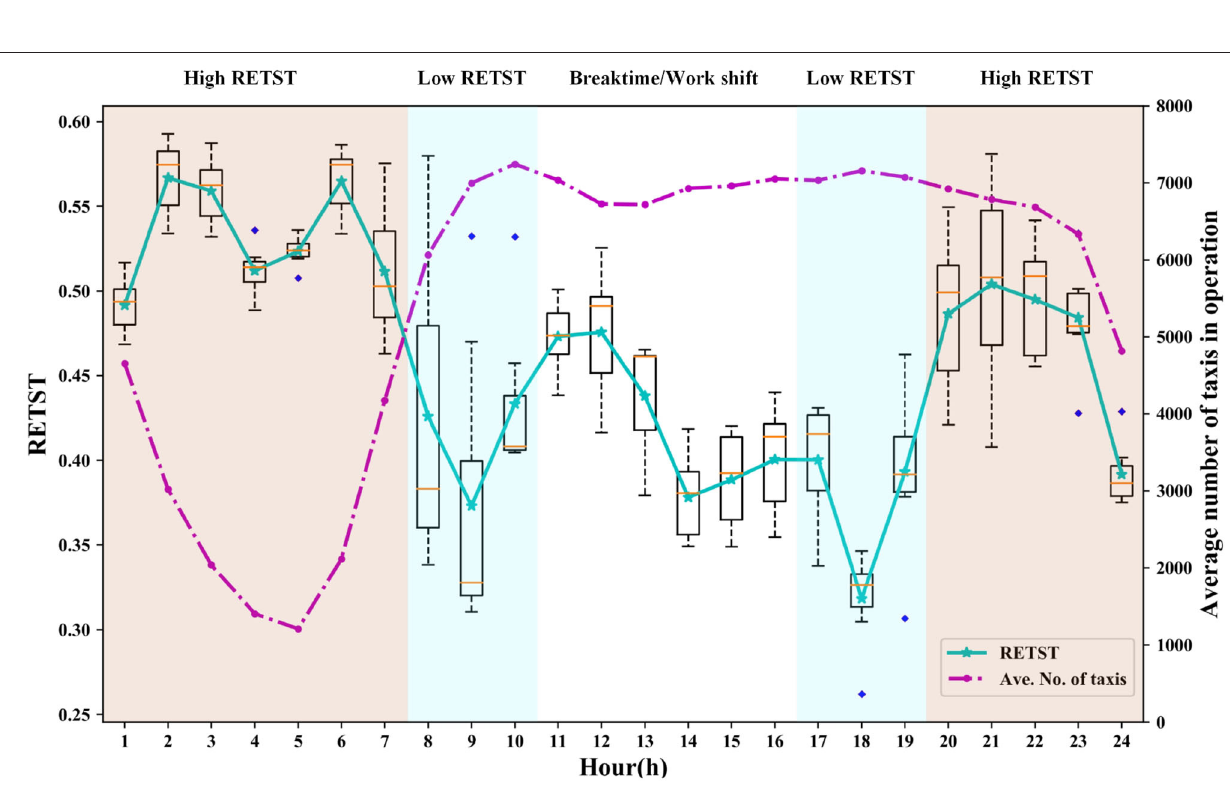
Frontiers in Public Health |